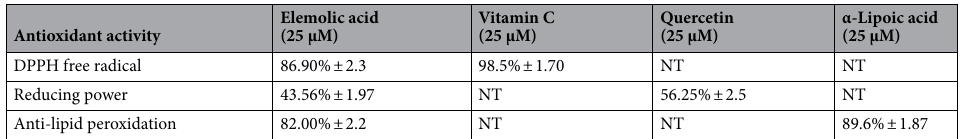
Table 5. The in vitro antioxidant activities of elemolic acid. Antioxidant activities, DPPH free radical scavenging activity, reducing power activity, and anti-lipid peroxidation were tested for elemolic acid and compared with standards such as vitamin C, quercetin, α-lipoic acid, respectively. NT, Not tested.